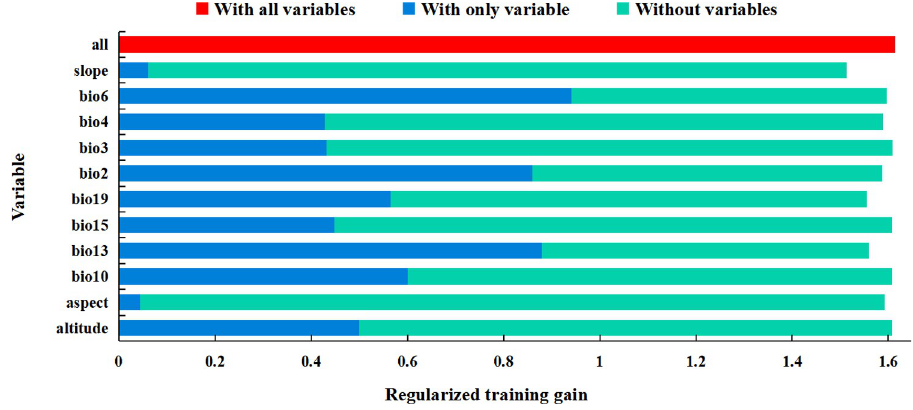
Fig 5. The Jackknife test result of environmental variables of P . tatarinowii